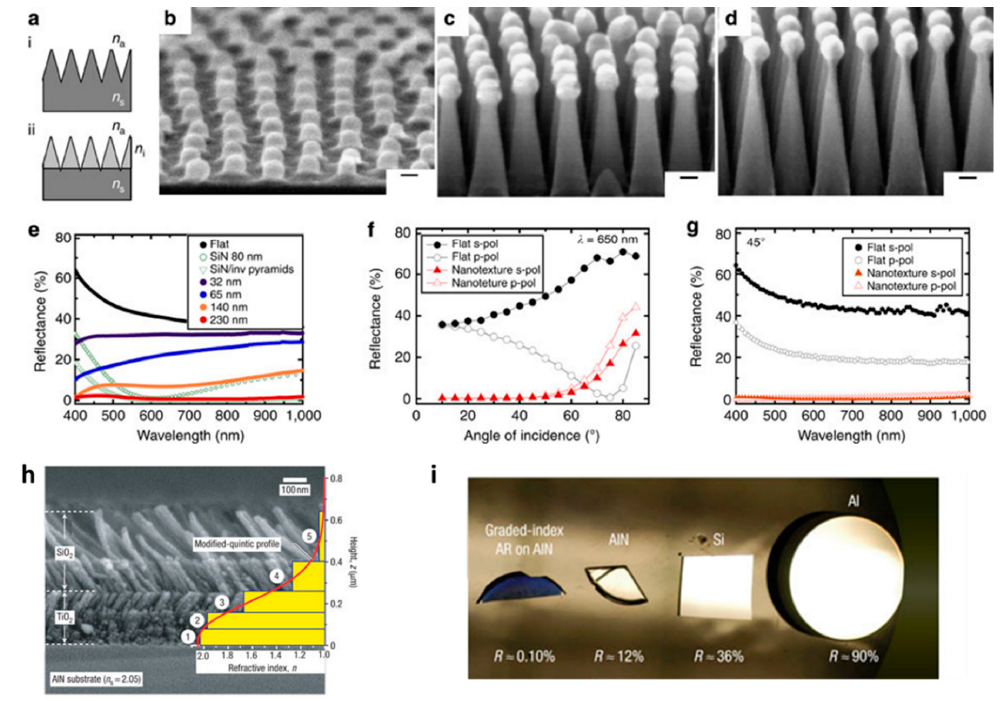
Figure 5. ( a ) Schematic (i) tapered antireflection nanotexture and (ii) tapered nanotexture with graded refractive index; ( b ) 70° Angle cross-sectional scanning electron microscope (SEM) image of close-packed alumina nanostructures formed by infiltrating a 99 kg-mol − 1 cylindrical phase polystyrene-b-poly(methyl methacrylate) block copolymer. Scale bar, 20 nm; ( c , d ) 70° cross-sectional SEM images of nanotextures fabricated by ( c ) 60 s and ( d ) 100 s of plasma etch. Scale bar, 20 nm; ( e ) Measured reflectance versus λ for a flat Si film, an 80 nm thick silicon nitride film and nanotextures with ℓ = 52 nm and t ranging from 32 to 230 nm. Also shown is the simulated reflectance of an 80 nm thick silicon nitride film on chemically etched inverted pyramids; ( f ) Measured reflectance (at 650 nm) for s- and p-polarization versus incidence angle for flat silicon (black circles) and nanotextures with ℓ = 52 nm and t = 230 nm (red triangles); ( g ) Measured reflectance of s- and p-polarization versus λ (45° incidence angle) for nanotextures with ℓ = 52 nm and t = 230 nm height (Adapted with permission from [108]; Copyright 2015, Nature Publishing Group); ( h ) Cross-sectional SEM image of